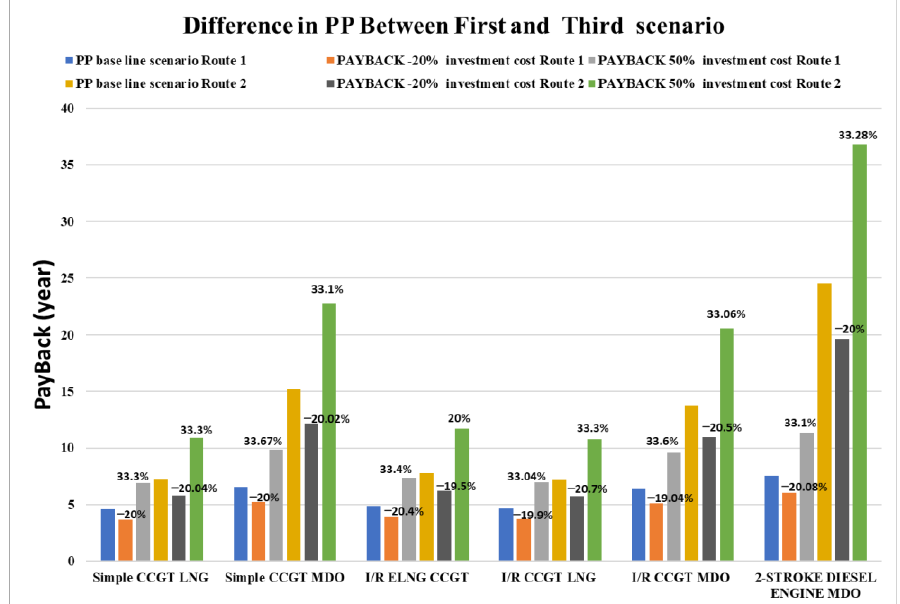
Figure 8. Difference in PP between the first and third scenarios for Routes 1 and 2.